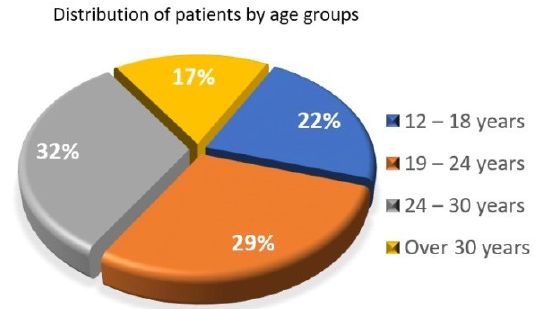
Figure 1. Distribution of patients by age groups.